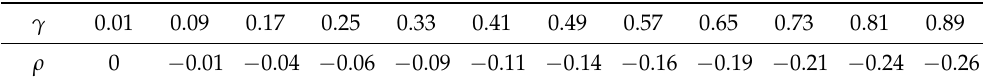
Table 14. Values of the rho of Spearman of the TGCC copula for θ = ( − γ ,1/ values of γ ∈ ( 0,1 ] , belonging to Configuration